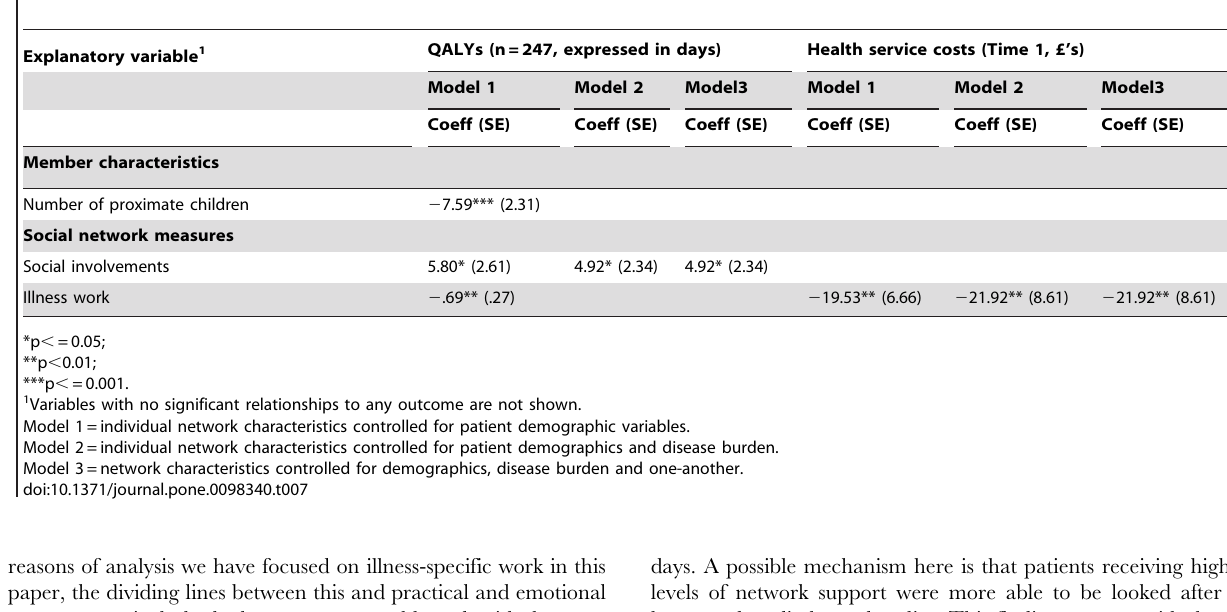
Table 7. Summary of regression analyses of health economics outcomes.